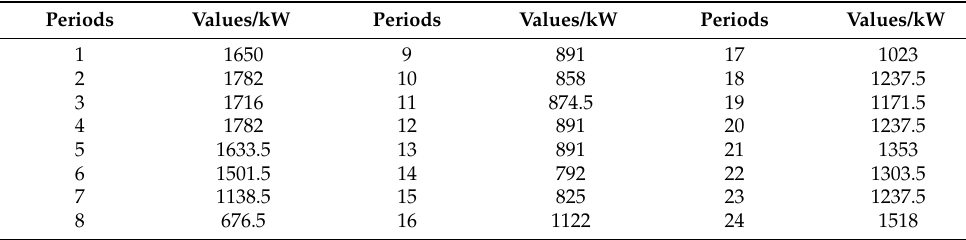
Table 5. Predicted values of wind turbine